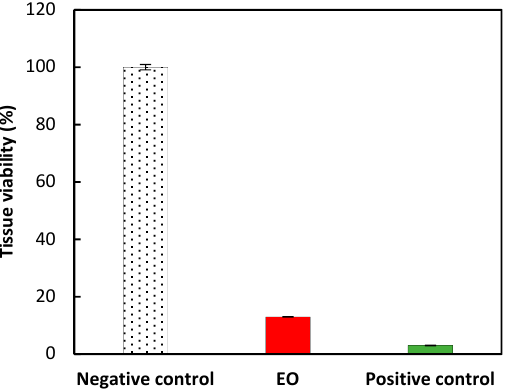
Figure 2. Tissue viability was recorded from the eye irritation test. Negative control (methyl acetate, 100% viability), EO (13% viability) and positive control (PBS without Ca 2+ /Mg 2+ , 3% viability). Results are expressed as mean ± standard deviation (triplicate).